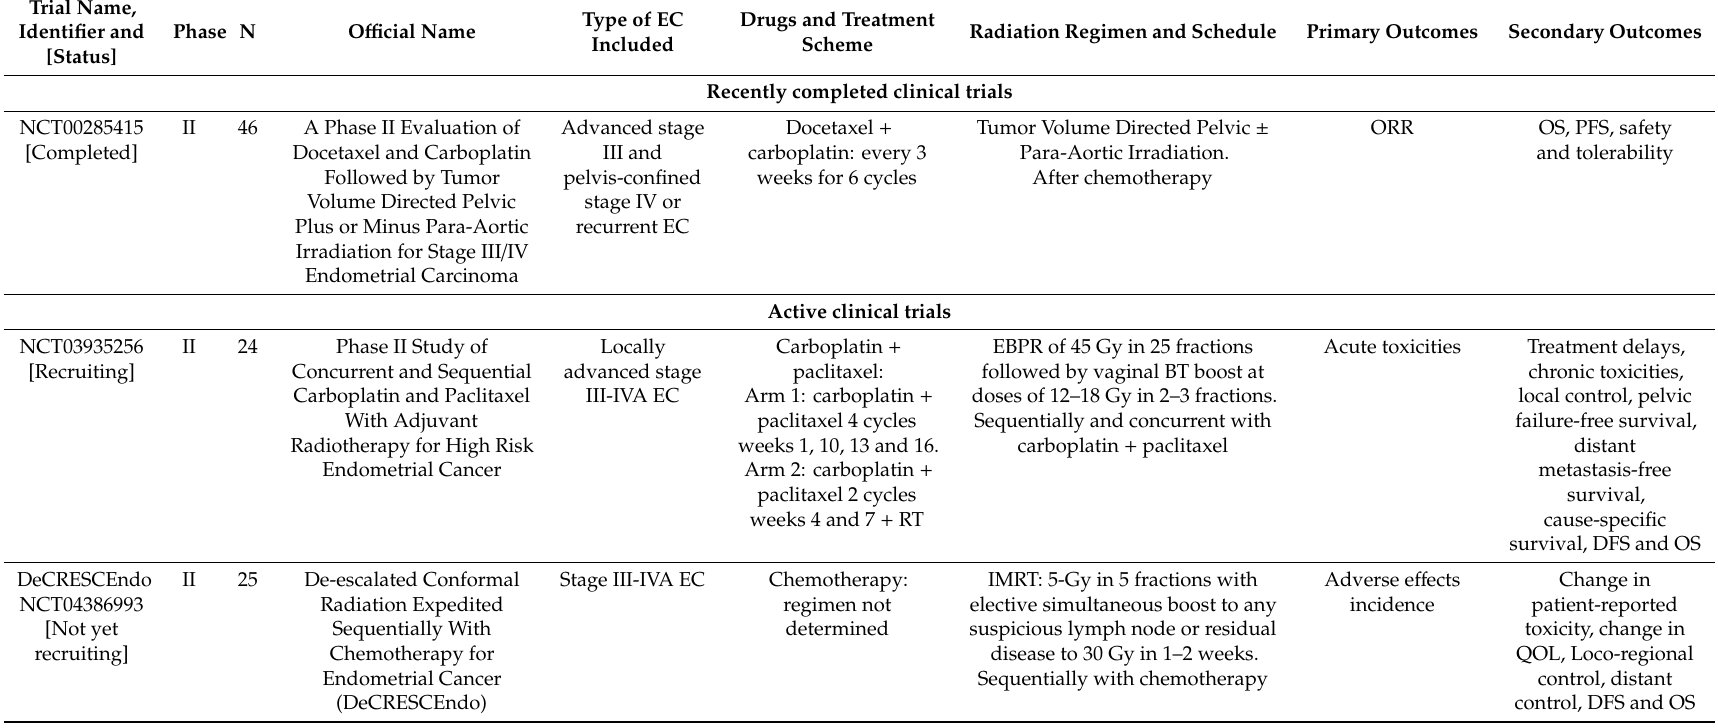
Table 2. Recently Closed and Active Clinical Trials Employing Chemotherapy Combined with